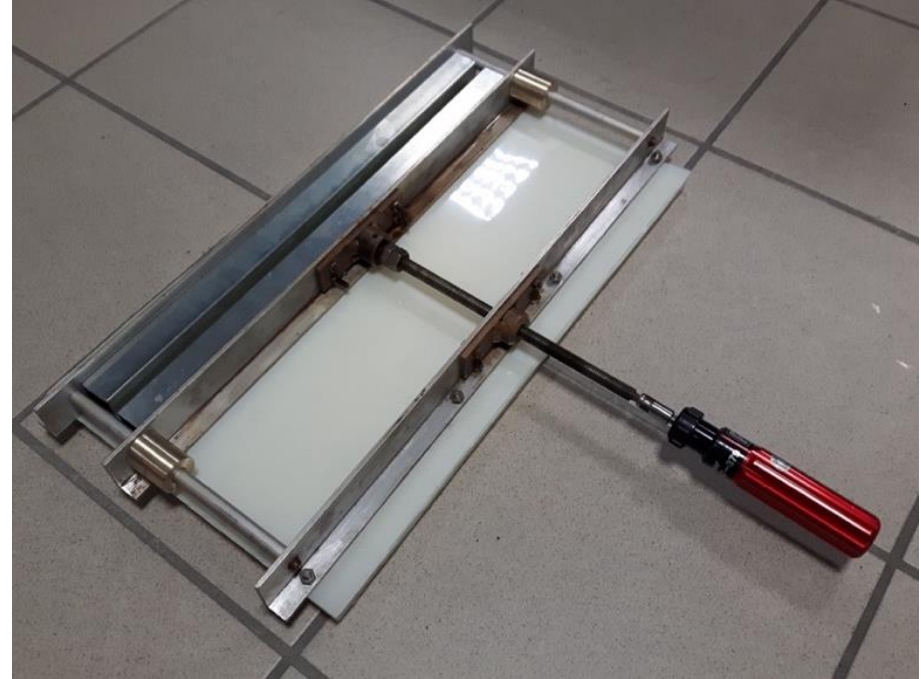
Figure 2. Screw driven mold used for healing along with the torque wrench.